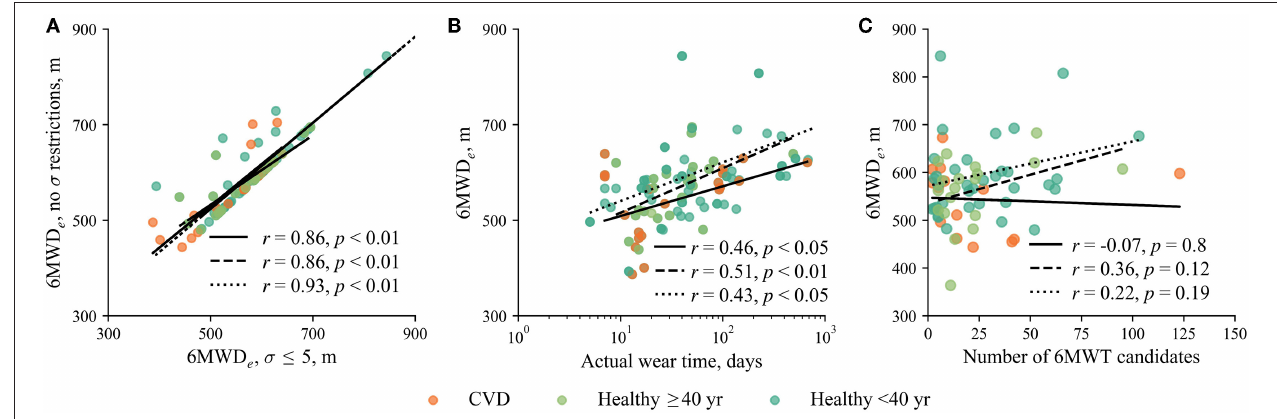
FIGURE 3 | (A) The relationship between the 6MWD e with and without restriction to cadence variation. (B) The relationship between the 6MWD e and actual wear time when σ ≤ 5 steps. (C) The relationship between the 6MWD e and the number of 6MWT candidates when σ ≤ 5 steps. Solid, dashed, and dotted regression lines represent patients with CVD, healthy subjects over 40-years-old, and healthy subjects below 40-years-old, respectively. In this figure, analysis time interval T = 1 week, resulting in 23 patients with CVD, 21 healthy subjects over 40-years-old, and 45 healthy subjects below 40-years-old, who had at least a single eligible 6MWT. The 6MWT with the largest 6MWD e over the entire monitoring duration is selected. Note that the beginning and the end of the regression line are determined by the group of subjects it applies to.